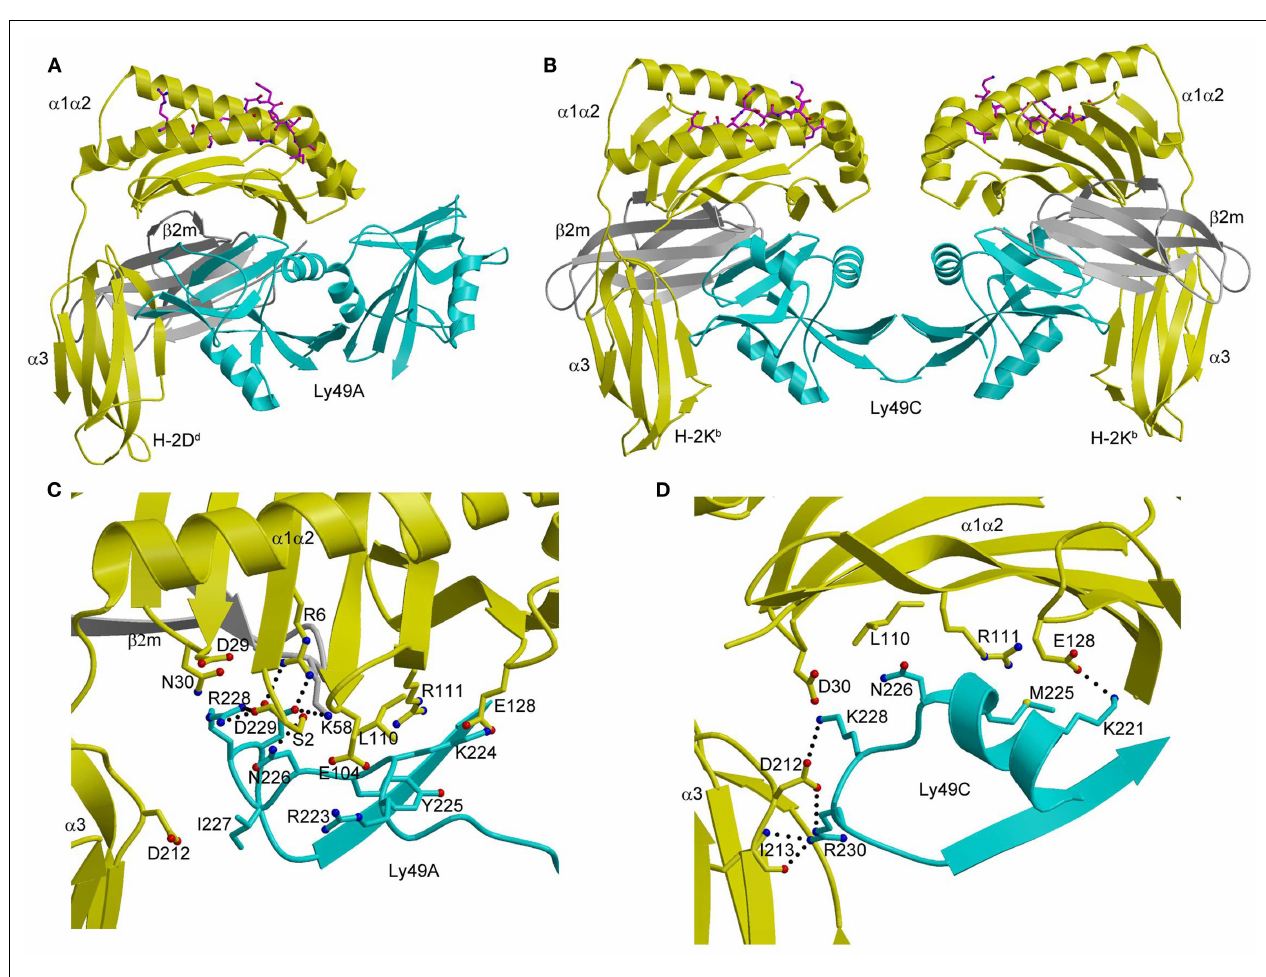
complex with H-2K b (3C8K). (C) The Ly49A–H-2D d interface, highlighting interactions made by residues 211–231 of Ly49A. (D) The Ly49C–H-2K b interface, showing interactions made by the corresponding region of Ly49C. The side chains of interacting residues are drawn in ball-and-stick representation, with carbon atoms in cyan (Ly49A or Ly49C), yellow (H-2D d or H-2K b ), or gray ( β 2 m), oxygen atoms in red, and nitrogen atoms in blue. Hydrogen bonds are represented by dotted